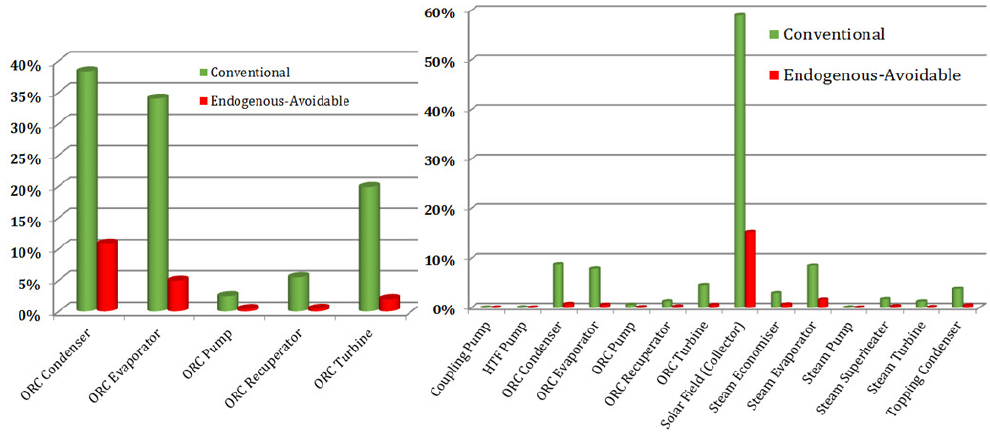
Figure 11. Comparisons of exergy analysis results including conventional and advanced (in the GPP and SGPP).